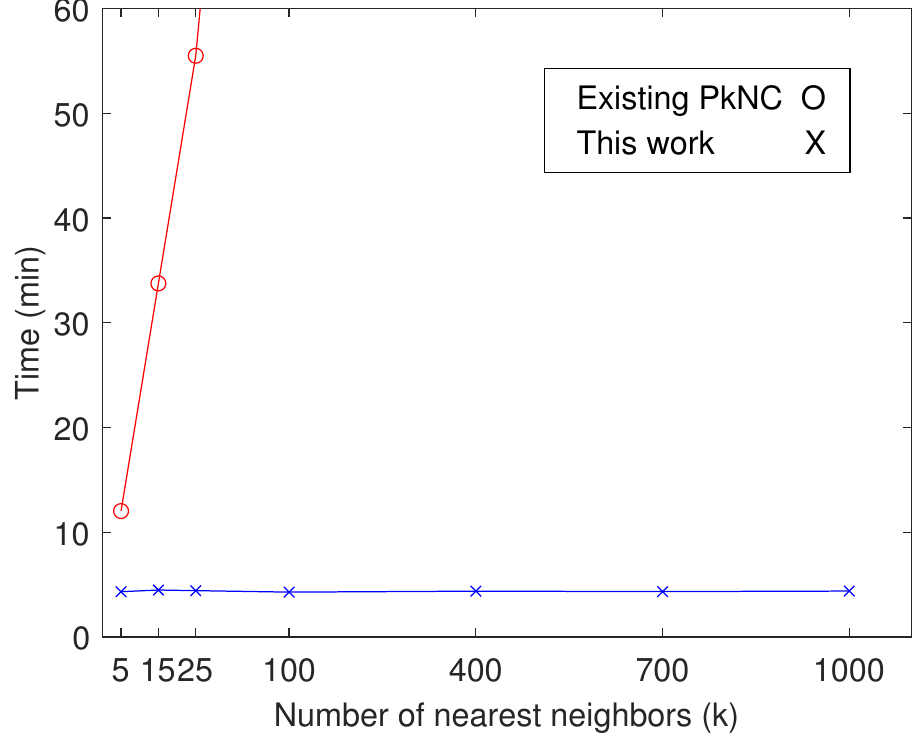
Figure 3. Running time comparison of our P k NC and the existing P k NC [11] for the number of nearest neighbors ( k